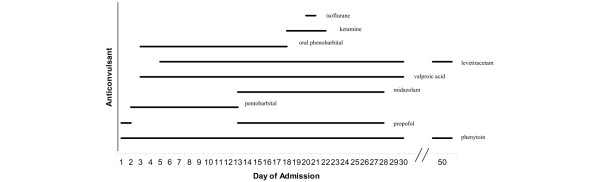
Anticonvulsant therapy timeline.